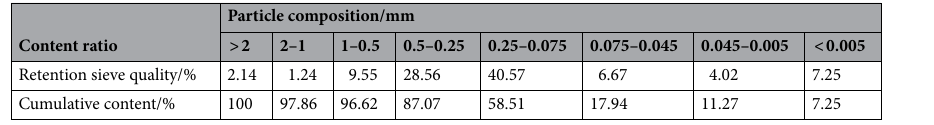
Table 1. Composition of tailings